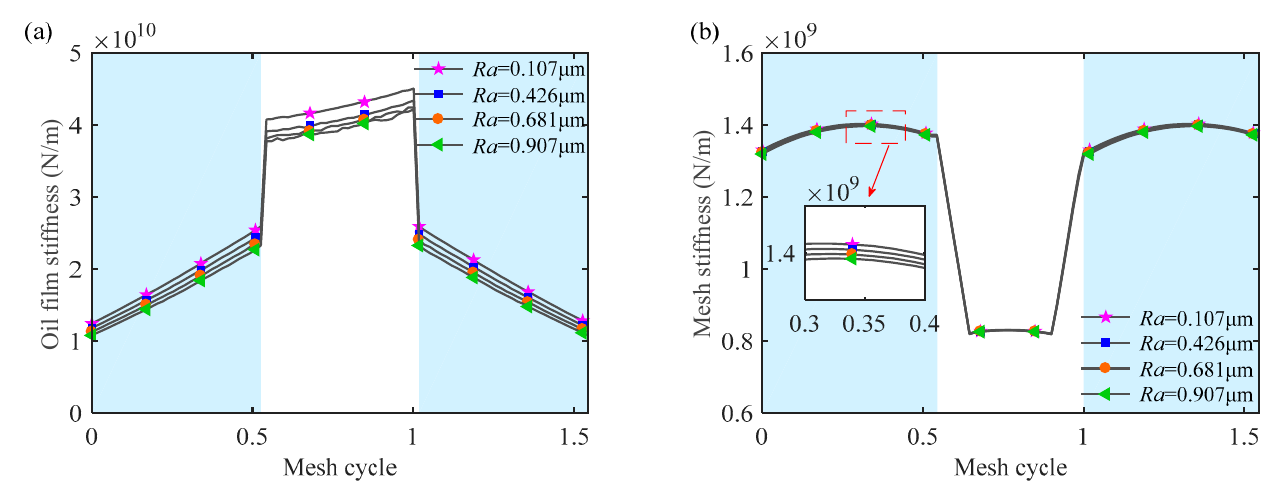
Figure 13. OFS and TVMS of gear under different roughness levels: ( a ) OFS; ( b ) TVMS.